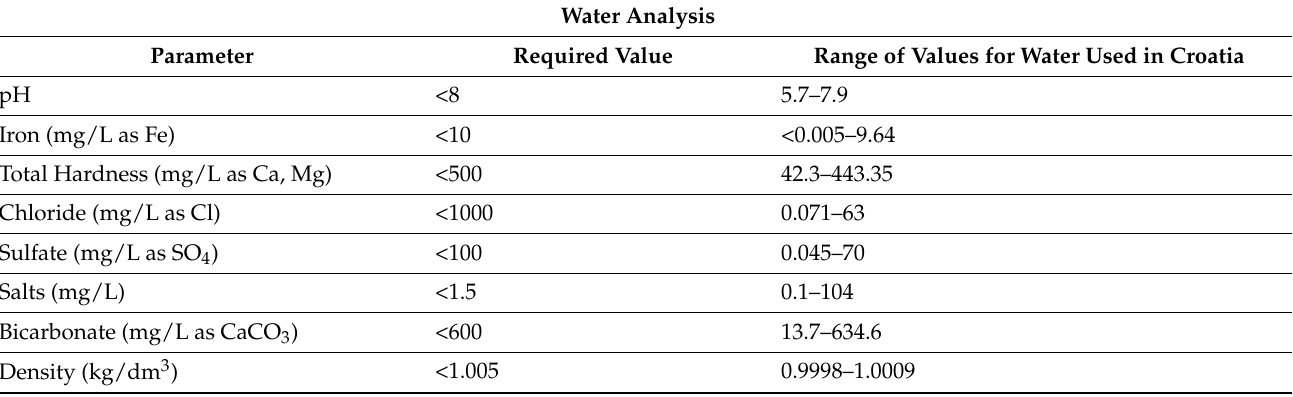
Table 2. Water analysis [3].